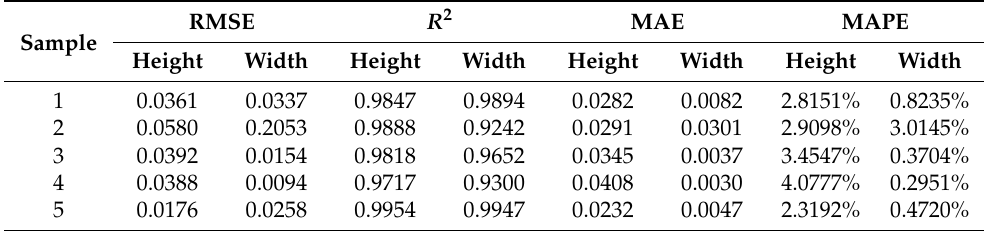
Table 2. Model performance for different